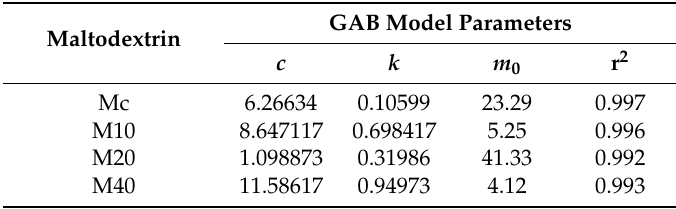
Table 2. Fitting constants of the GAB model for water adsorption in the